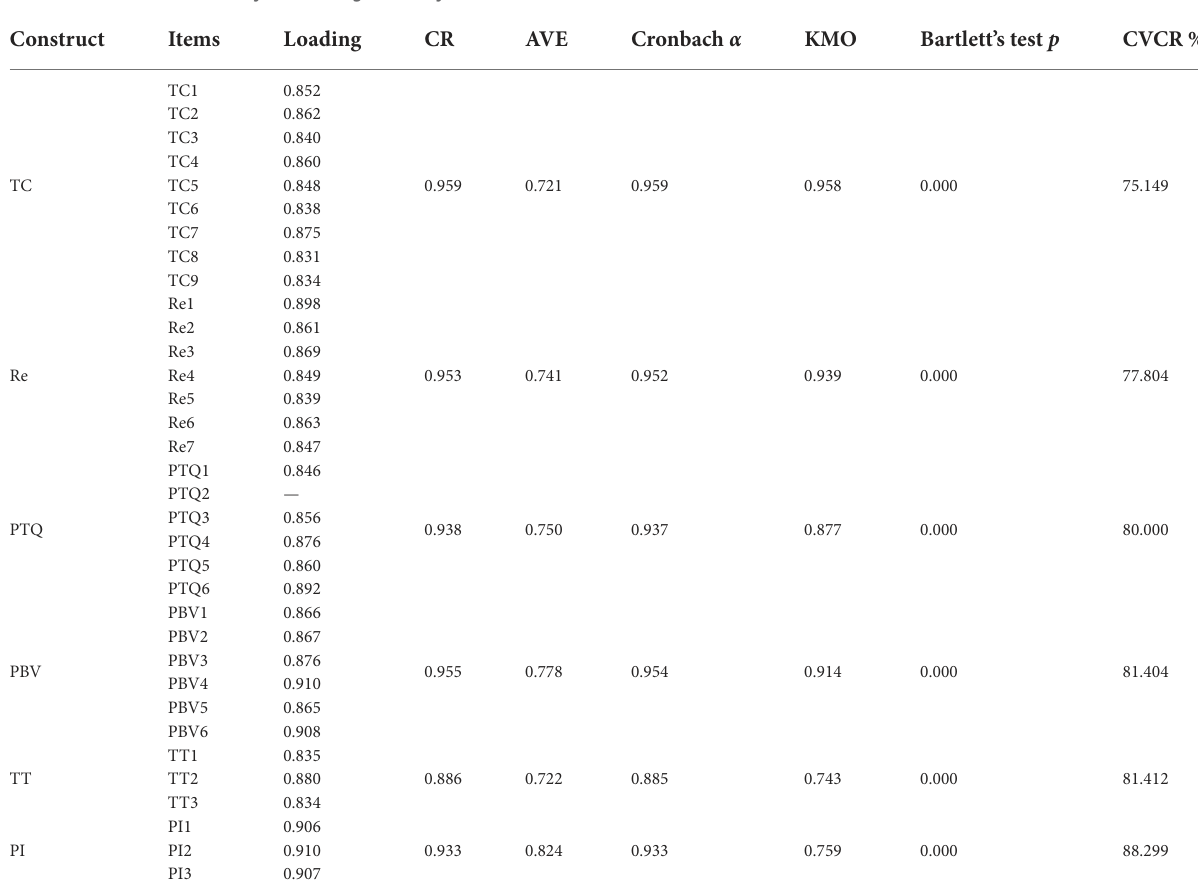
TABLE 3 Theresultsofreliabilityandconvergentvalidity.